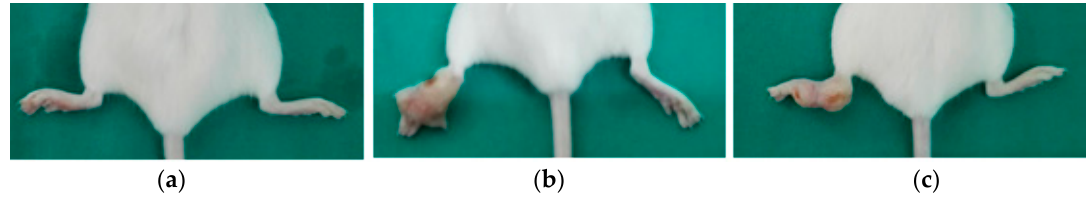
Figure 2. Pictures of footpads from BALB/c mice infected with L. amazonensis at 10 weeks p.i. ( a ) Animal treated with extract from S. havanense ; ( b ) untreated animal; and ( c ) animal treated with GTM.